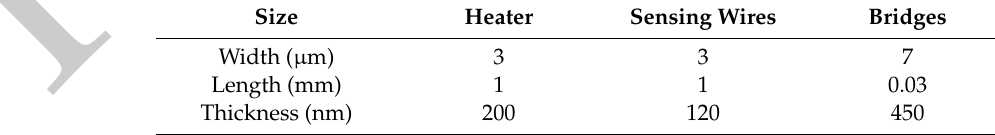
Figure 1. Overview of the calorimetric sensor design. Table 1. Calorimetric sensor geometric sizes.